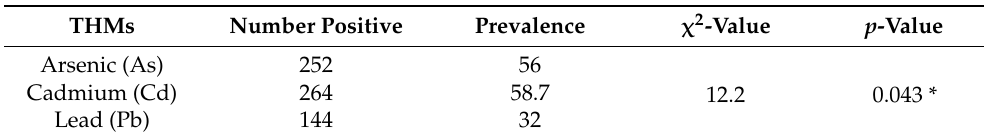
Table 3. Statistical prevalence of toxic heavy metals (THMs) in goat carcasses ( n = 450) processed for human consumption in Enugu State, Nigeria.